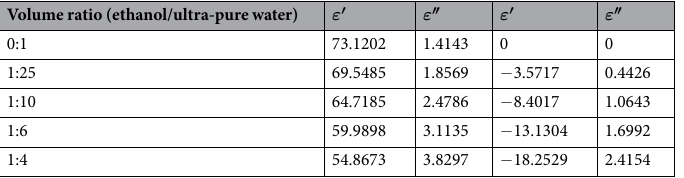
Table 1. The calculated value and their difference in different volume ratio of ethanol/ultra-pure water (2.45 GHz, 25